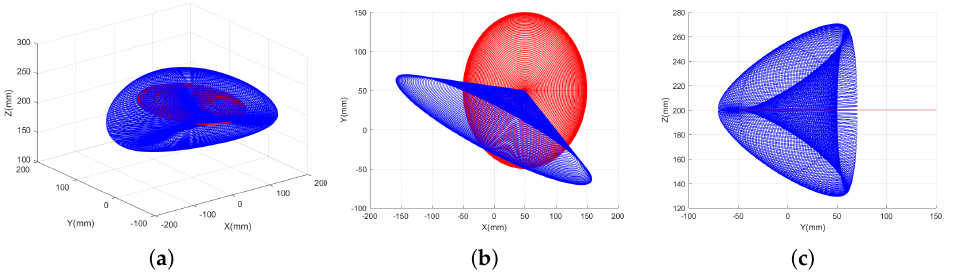
Figure 6. Parasitic motions of Hybrid Mechanism 1 (red) and Hybrid Mechanism 2 (blue), which are, respectively, given by Equations (13) and (15): ( a ) 3D view, ( b ) top view, and ( c ) side